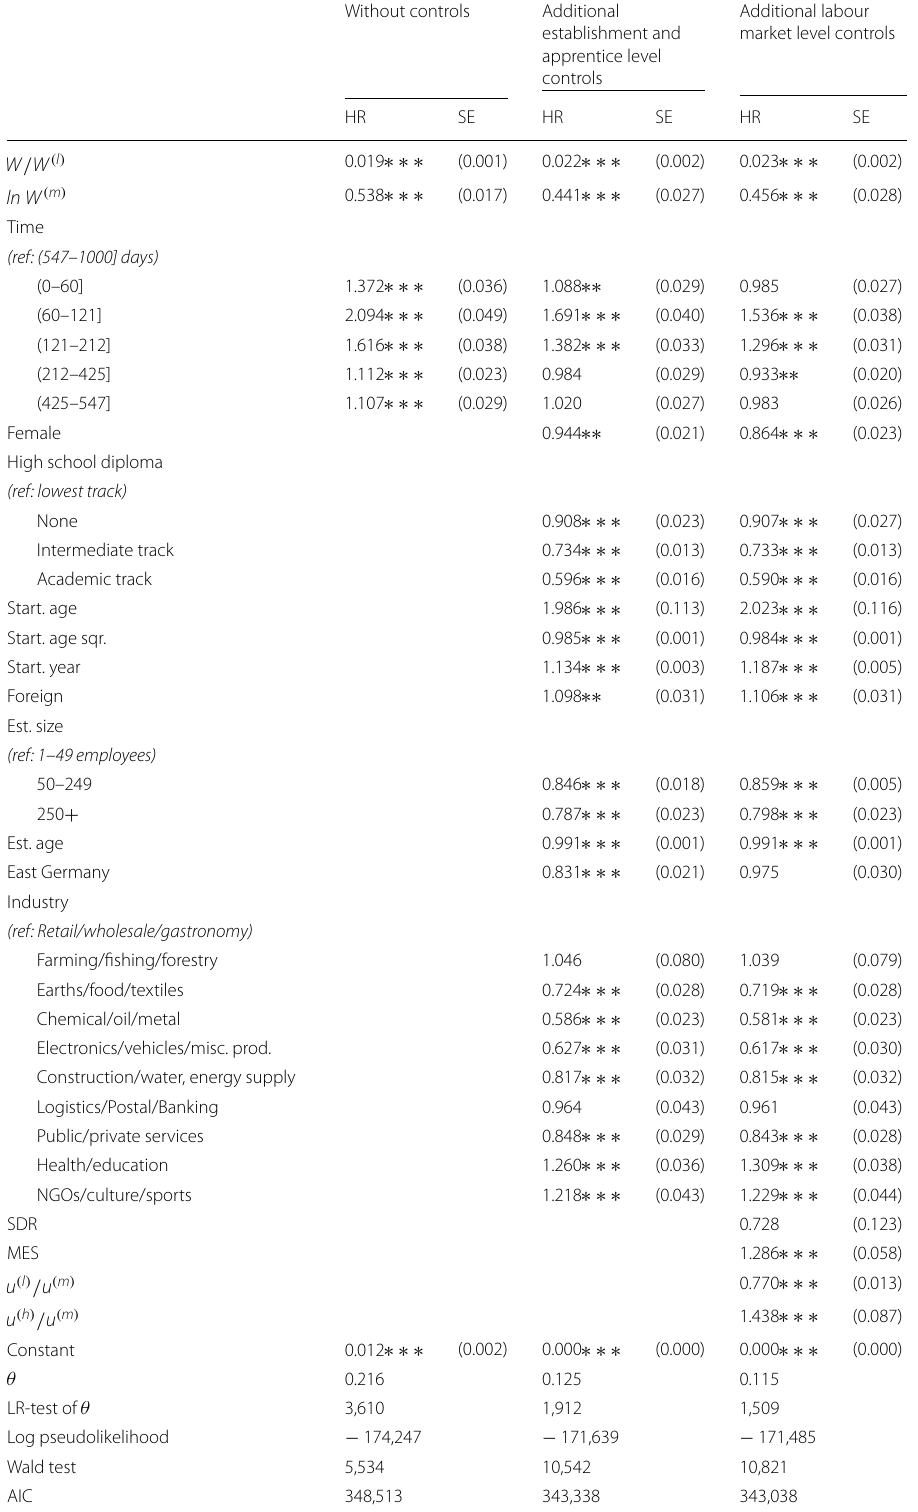
Table 3 Estimated hazard ratios for the piecewise exponential models of the apprenticeship non‑ completion hazard